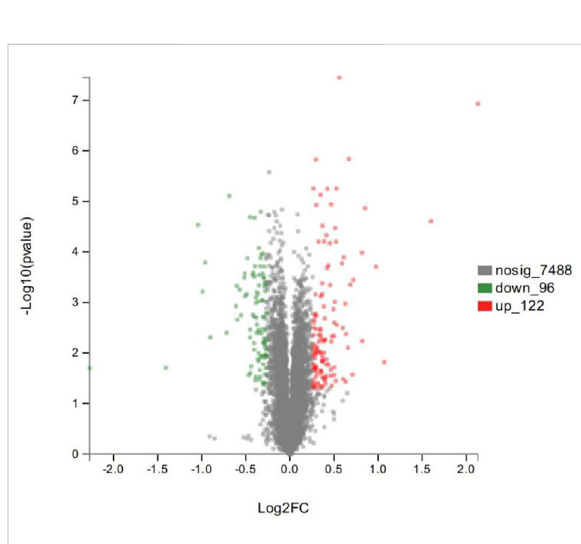
FIGURE 5 Volcano plot showing signi fi cantly up- (red) or down- regulated (green) proteins between the artemisinin treatment group and the control group. The gray points are proteins whose expression levels did not change signi fi cantly. The abscissa shows multiples of difference (logarithmic transformation of 2), while the ordinate is signi fi cant difference ( p value, logarithmic transformation of